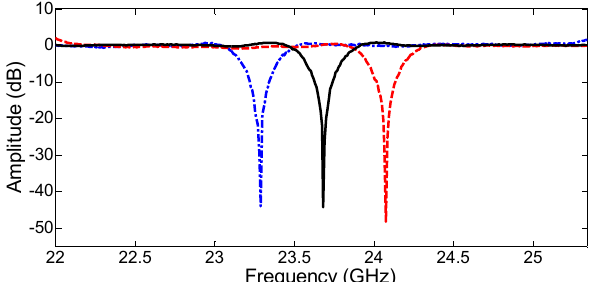
Figure 4. ( a ) The measured frequency response and group delay response within the notch filter − 3 dB operating frequency range. ( b ) Measured tunable notch filter response with a notch frequency of 21.84 GHz (blue dashed line) and 22.16 GHz (red solid line) obtained by introducing different phase shifts to the radio frequency (RF) modulation sidebands.